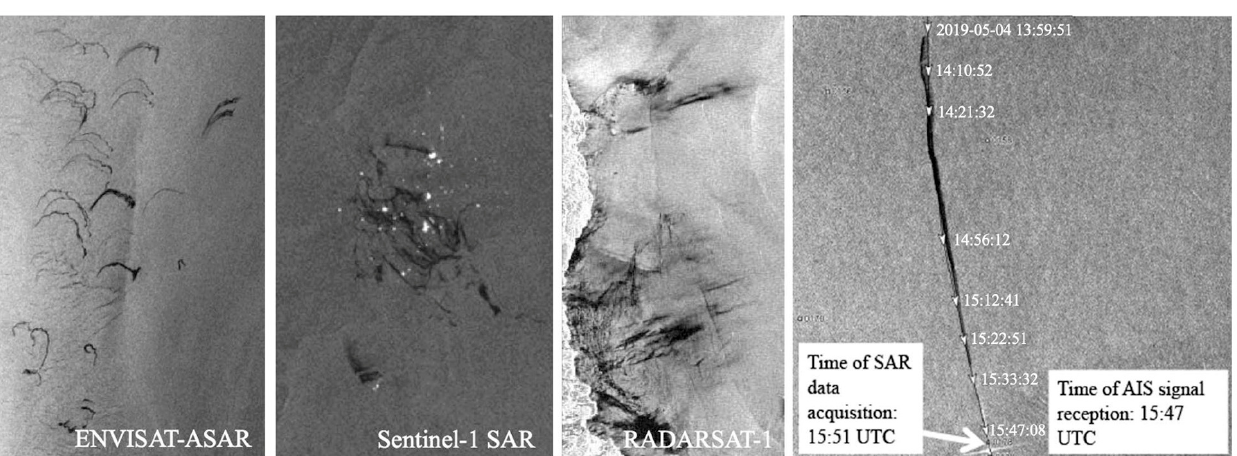
Figure 16. From left to right: Natural oil seeps, oil slicks from off-shore oil-rigs, low wind and up-welling look-alikes, and illegal oil discharged by a ship identified by the automatic identification system (AIS) signals.